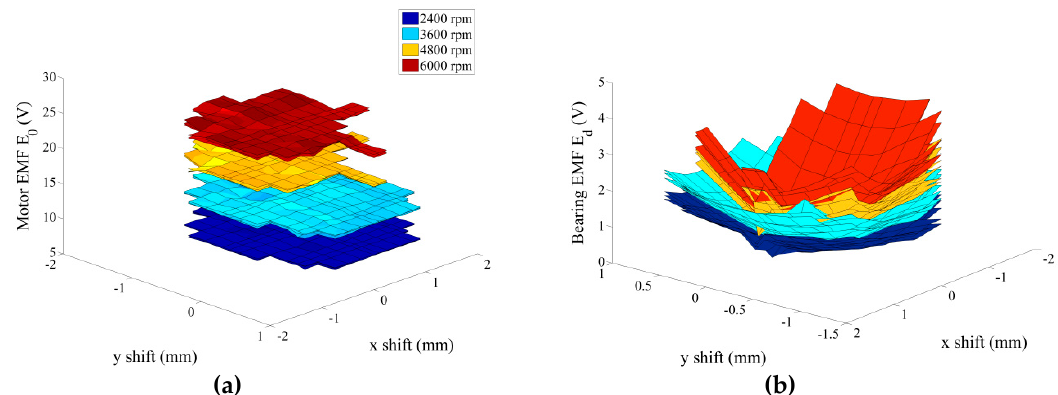
Figure 11. RMS values of ( a ) motor electromotive force E0 and ( b ) bearing electromotive force Ed as a function of the rotor position in the x–y plane for spin speeds of 2400, 3600, 4800, and 6000 rpm.